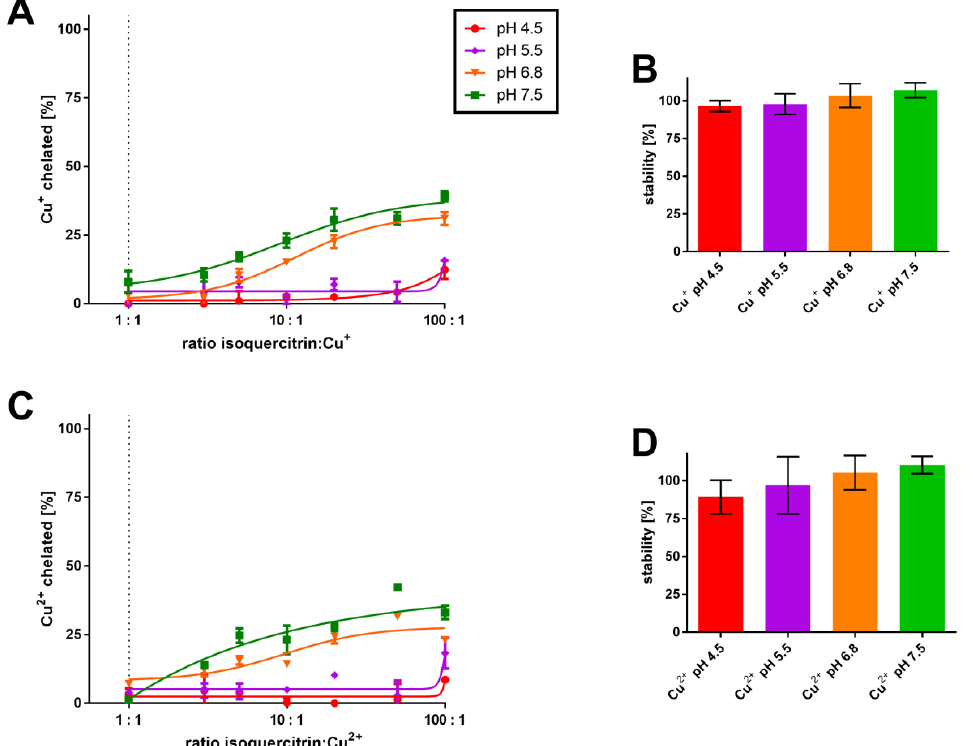
Figure 4. Copper chelation in highly competitive ambient (BCS method). ( A ) Cu + chelation with corresponding complex stability ( B ); Cu 2+ chelation ( C ) with respective complex stability ( D ). Isoquercitrin was mixed with copper ions (final concentration was kept the same in all experiments— 50 µ M) in different buffers for 2 min in the presence (cuprous ions) or absence of HA (cupric ions). HA was added thereafter in the case of Cu 2+ ions in order to reduce non-chelated copper. In the last step, the indicator BCS was added. Absorbance was measured immediately and after 5 min. The chelation results means the percent of metal chelation calculated vs . the blank sample containing copper ions without isoquercitrin after a 5 min measurement. Stability was calculated as the change of percentage of copper chelation after 5 min vs . the first measurement at time